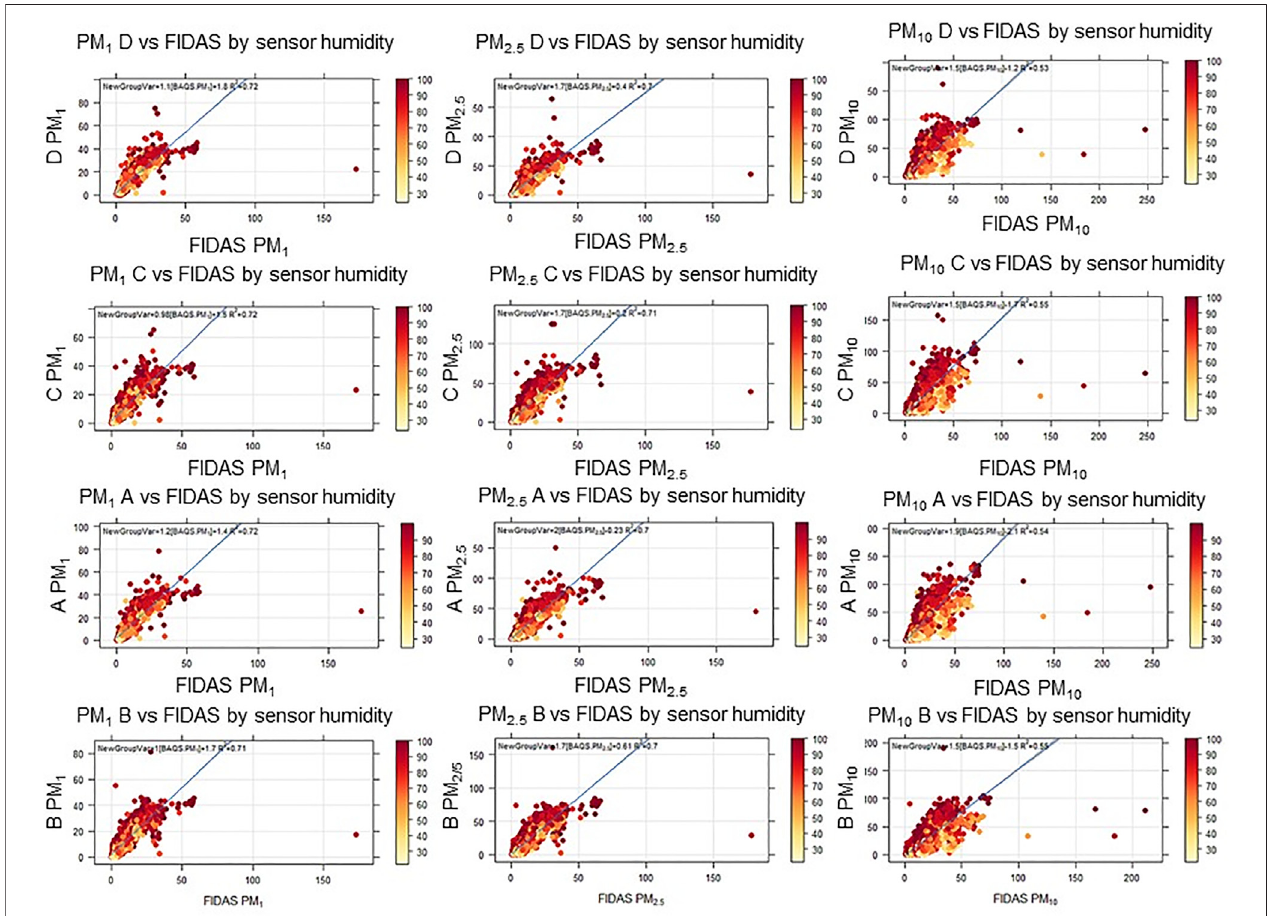
FIGURE 2 | Plots of particulate matter concentrations from low-cost sensor vs . FIDAS by humidity.